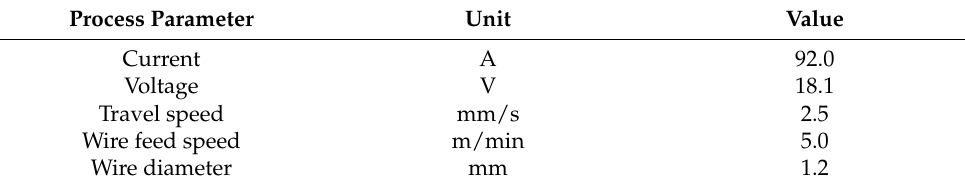
Figure 1. Experimental setup for additive manufacturing. Table 2. Used WAAM building